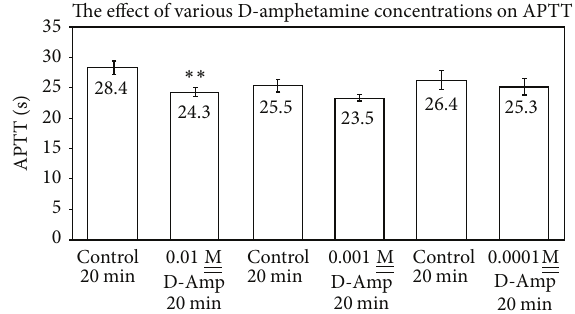
Figure5:EffectofvariousisoproterenolconcentrationsuponAPTT ( 𝑛 = 4 ; 𝑃 = 0.03 for 0.01M IP).